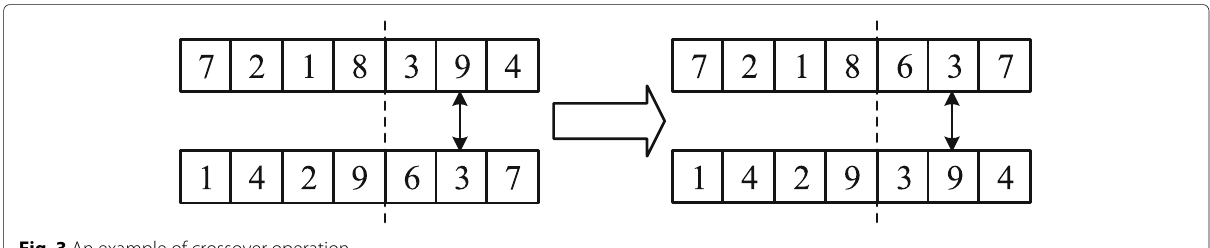
Fig. 3 An example of crossover operation